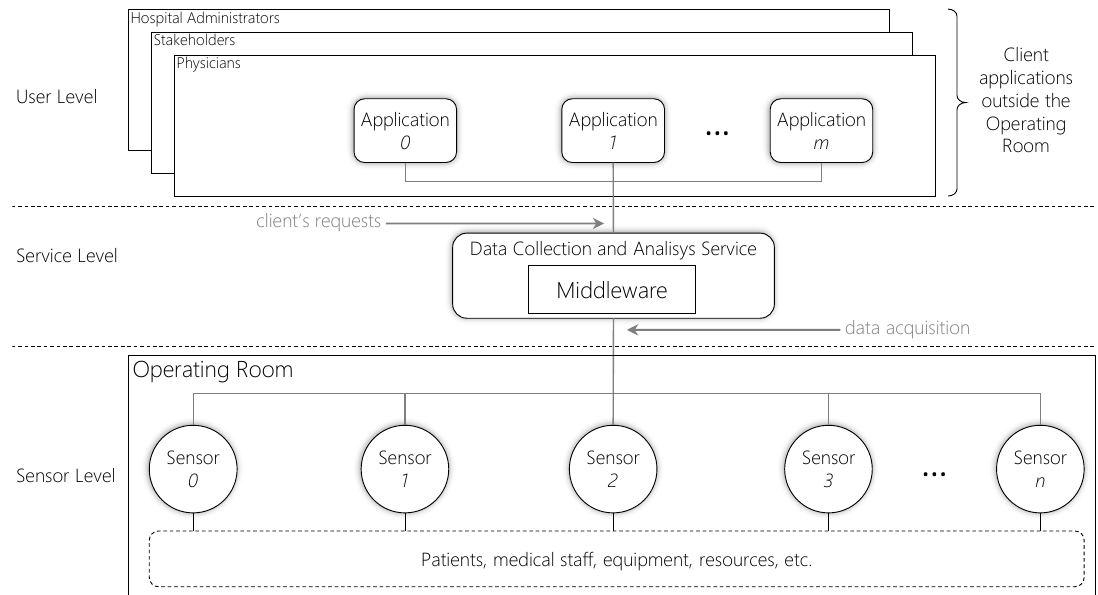
Figure 1. A monitored Operating Room model with a middleware acquiring and providing information in real time for user applications. The middleware is present in the service level, which can be deployed in a server or datacenter. As the number m user applications and n sensors increase, the middleware may decrease performance and consequently